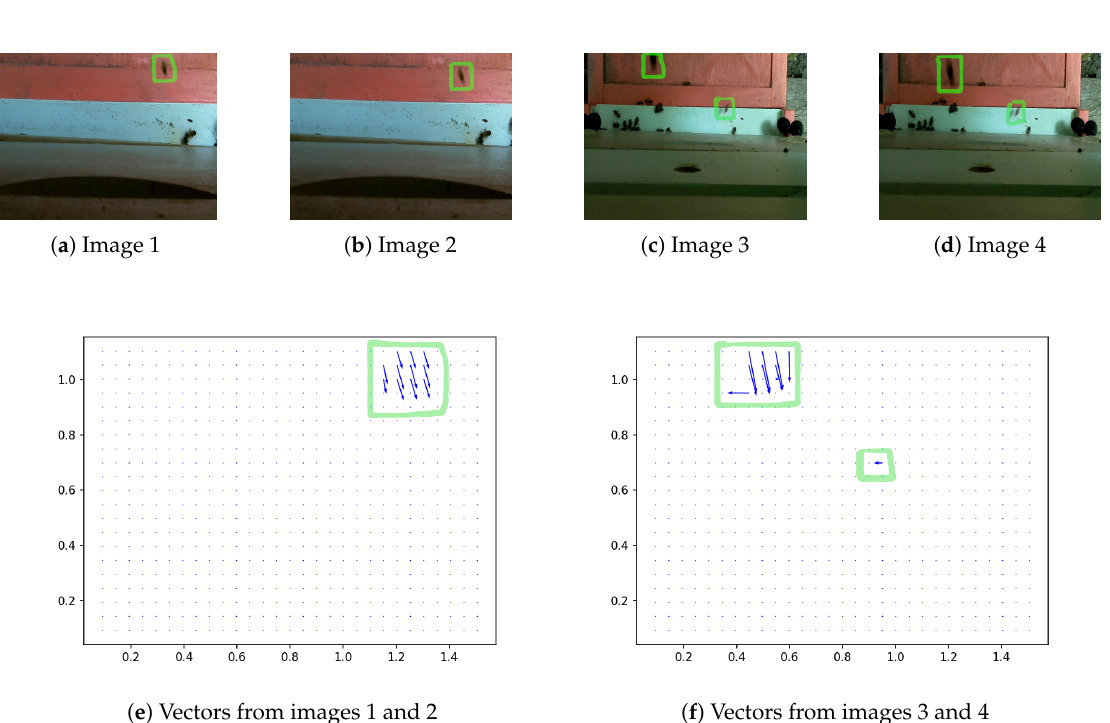
Figure 3. ( a , b ) Two consecutive frames selected from a 30-s video. ( c , d ) Two consecutive frames selected from a different 30-s video. The vector field in ( e ) is generated from the images in ( a , b ); the vector field in ( f ) is generated from the images in ( c , d